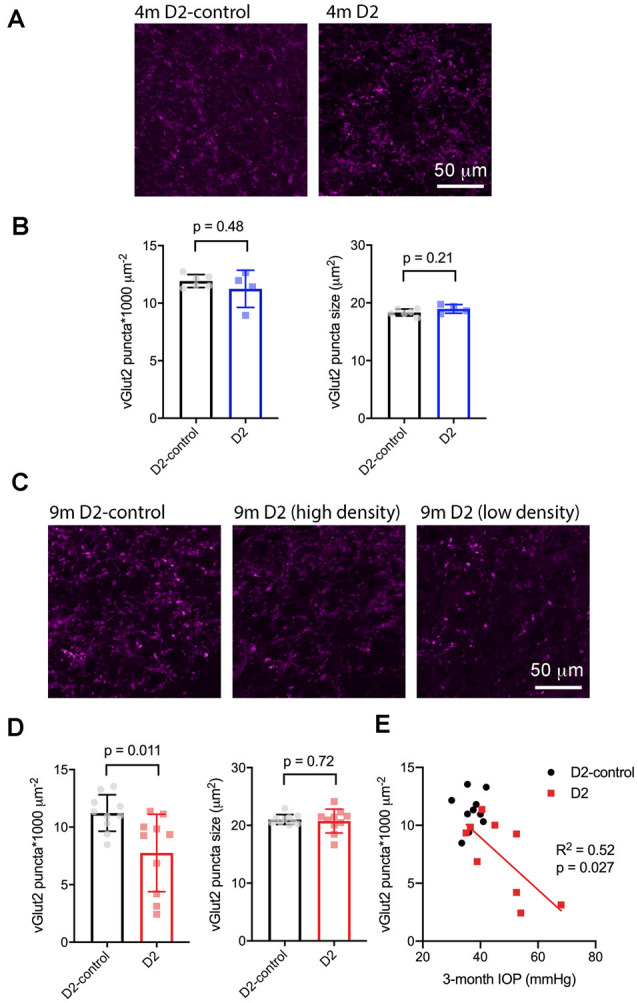
vGlut2-labeled RGC axon terminals are lost in an IOP-dependent manner in 9 m D2 mice. (A) 2.5-micron-thick maximum intensity projections of vGlut2 staining from the dLGN core of 4 m D2-control (n = six mice) and D2 mice (n = four mice). (B) Neither density nor size of detected vGlut2 puncta was significantly different between D2-control and D2 mice at 4 m. (C) vGlut2 images from 9 m D2-control (n = 10 mice) and D2 mice (n = 10 mice). For D2 mice, images are shown from mice with higher vGlut2 density (middle panel) and lower vGlut2 density (right panel) to illustrate the range of labeling seen. (D) vGlut2 density is significantly reduced in 9 m D2 mice compared to D2-controls (unpaired t-test) while vGlut2 puncta size is not different. (E) vGlut2 density in 9 m D2 mice dLGN sections significantly correlated with the 3-month cumulative IOP as assessed with linear regression.